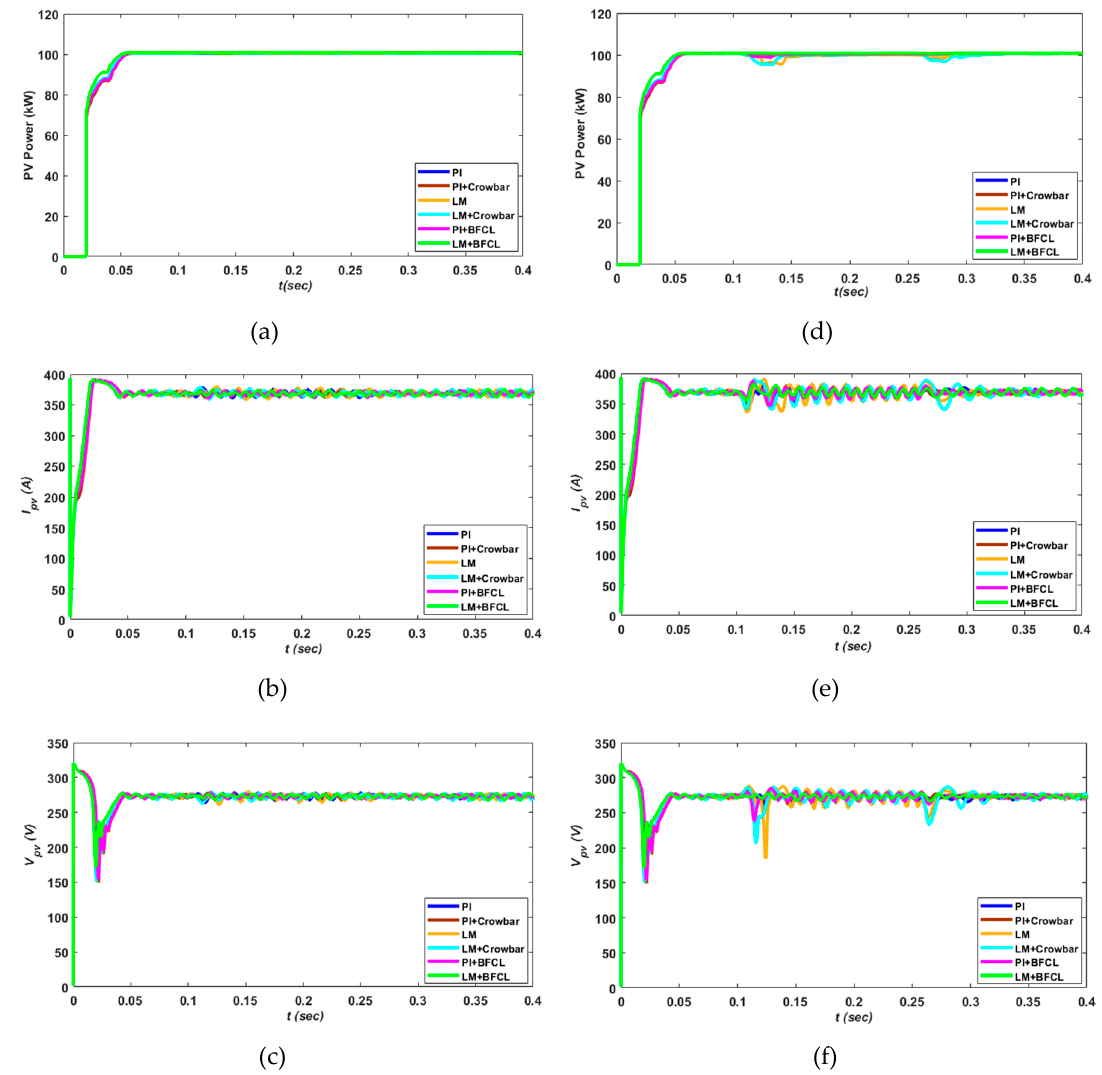
Figure 25. PV output power, current, and voltage during the P-G fault ( a, b, c ) and the P-P fault ( d, e,